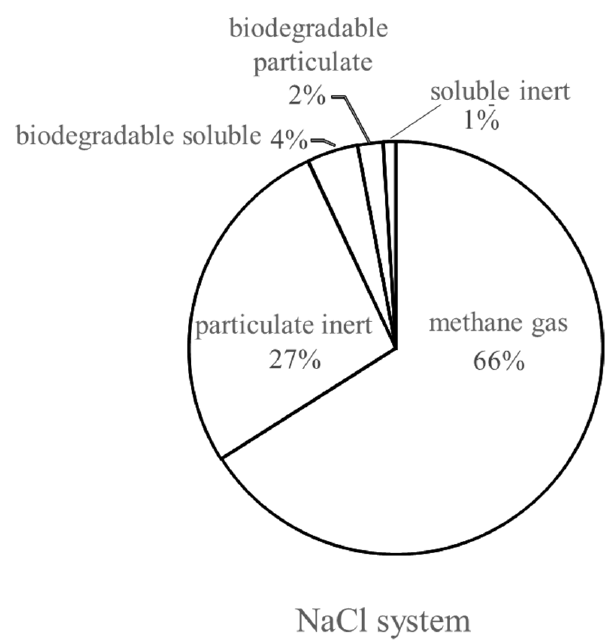
Figure 6. Conversion rate from the NaCl system in the steady state.